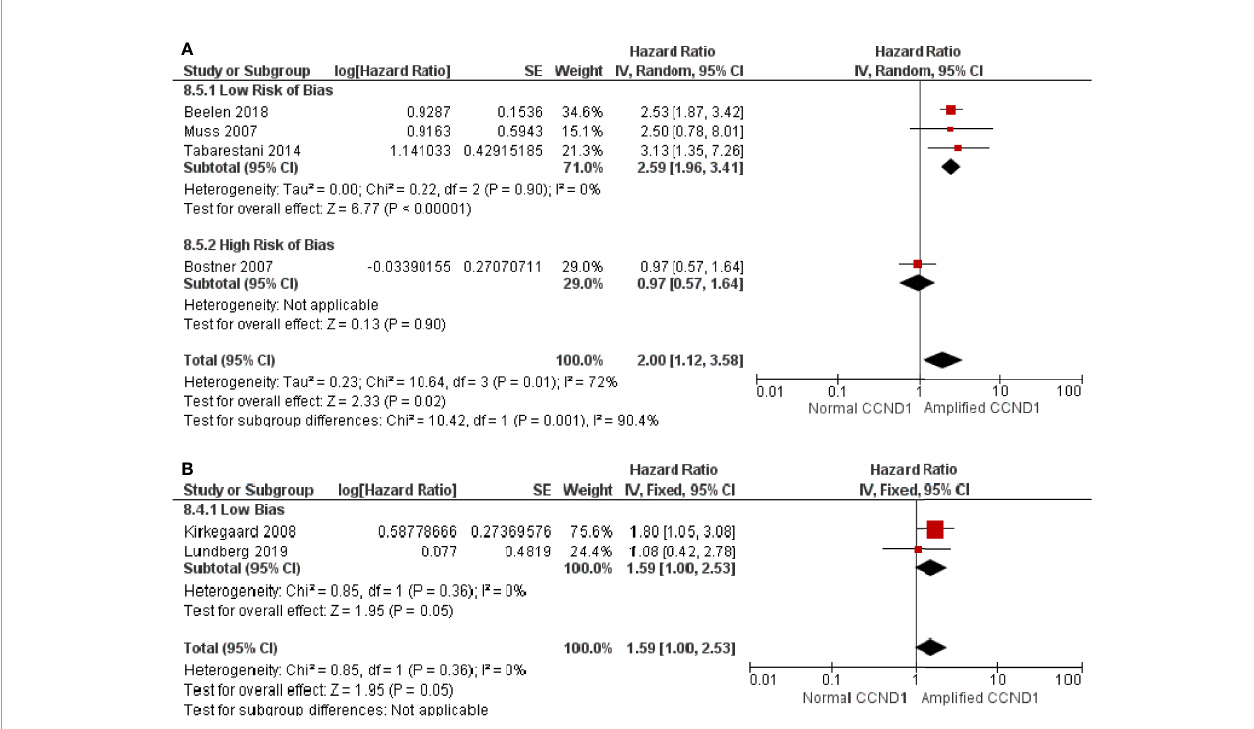
FIGURE 4 | Forrest plot of hazard ratios for CCND1 ampli fi cation and worse relapse free survival and overall survival of endocrine therapy breast cancer patients. (A) CCND1 Ampli fi cation and relapse free survival (B) CCND1 Ampli fi cation and overall survival. Z values indicate the magnitude of association, with p-values <0.05 indicating statistically signi fi cant association. Red squares indicate hazard ratio, with values >1 indicative of association of the outcome measure (RFS and OS) with CCND1 ampli fi cation, with strongest association towards the right of the plot. Black lines either side of squares indicate 95% con fi dence interval (CI). Size of red boxes is relative to speci fi c study weight with greatest weight given to studies with minimal variance (calculated based on inverse of the variance). Large black diamond represents pooled hazard ratio estimate of the above studies. A random effects approach was taken. SE, Standard Error. Plots were generated in Review